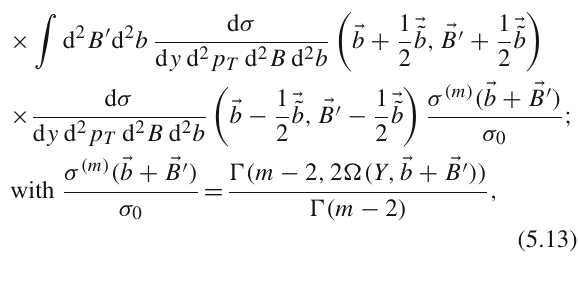
Fig. 8 v n versus multiplicities for hadron–hadron and hadron–nucleus